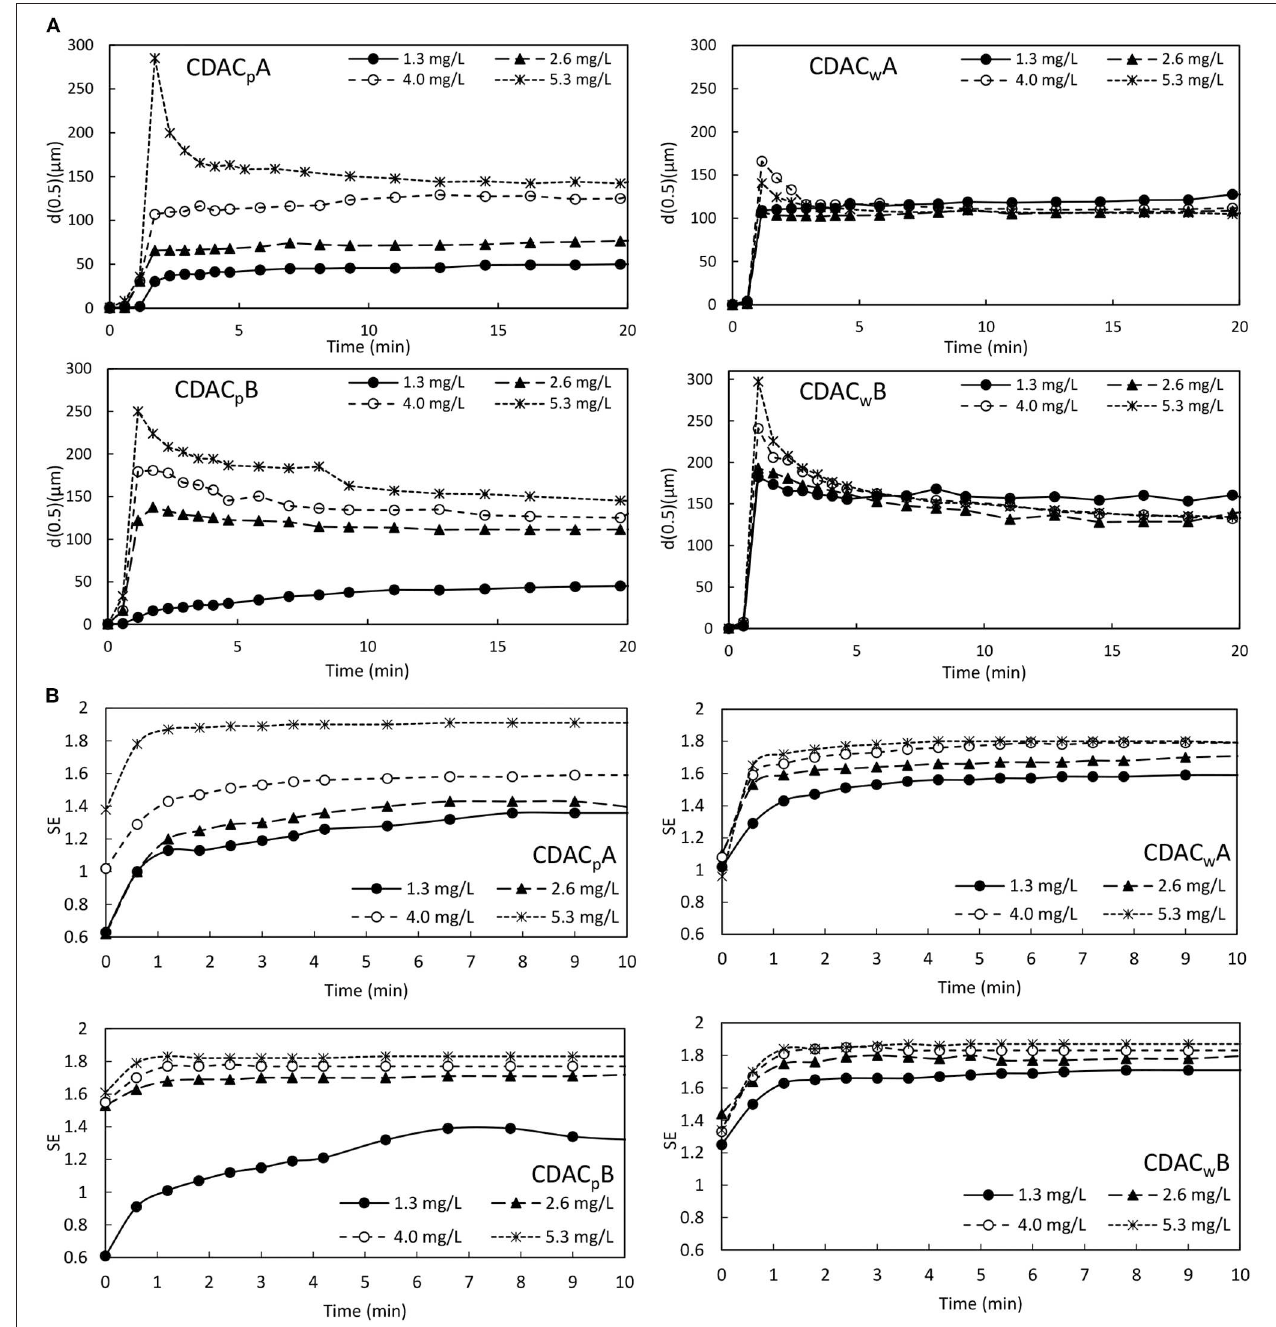
FIGURE 12 | Industrial effluent treatment - evolution of (A) median particle size (d(0.5)) and (B) floc structure (SE) over time, obtained via LDS, for four different flocculant dosages of cationic cellulose-based polyelectrolytes obtained from bleached pulp, CDAC p A, B and obtained from pulp with kappa number of 26.7, CDAC w A, B, combined with